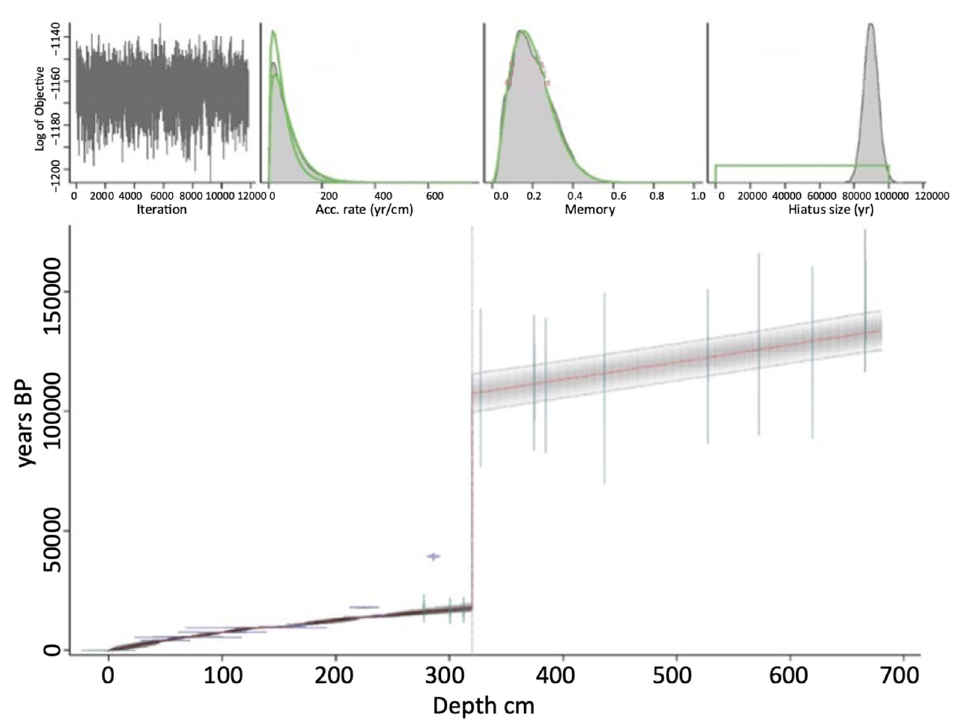
Figure 2. Age–depth model of LC2. An 89,700-year hiatus exists at 320 cm (~17.7–107.5 ka). OSL dates are represented in this diagram as light blue vertical lines. Radiocarbon dates are represented as light purple shaded four-point stars. Three OSL ages between 275–315 cm produced statistically identical ages of between 17.7 ± 1.4 ka and 16.0 ± 1.3 ka. The radiocarbon sample at t he same depth range (286 cm) returned an age of 39,244–38,248 years BP and was excluded from the model by the Bacon software program. The grey lines and shading represent 95% con fi dence intervals.